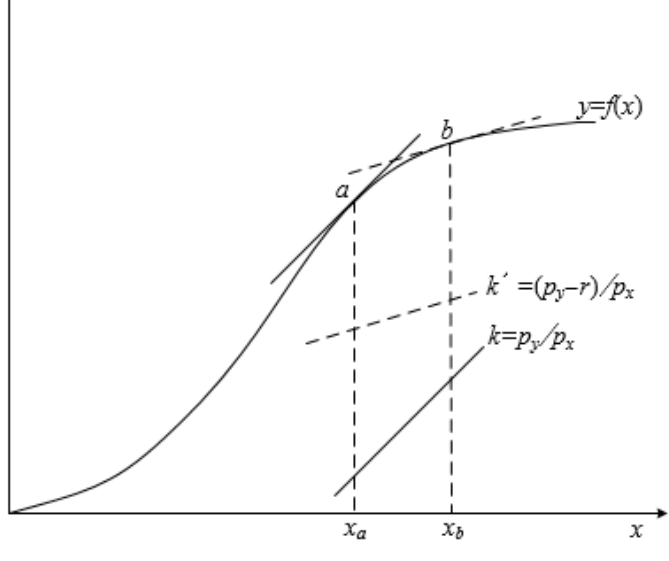
Figure 1. Utility maximization and farmers’ fertilizer use. When there is no production risk ( r = 0), the slope of the iso-utility line (the iso-profit line) is k = p x / p y , the equilibrium point of fertilizer use is a , and the fertilizer application rates are x a . When there is production risk ( r > 0), the slope of the iso-utility line is k’ = ( p x − r )/ p y , the equilibrium point of fertilizer use is b , and the fertilizer application rates are x b . x b > x a indicates that farmers apply more fertilizer to avoid production risk.